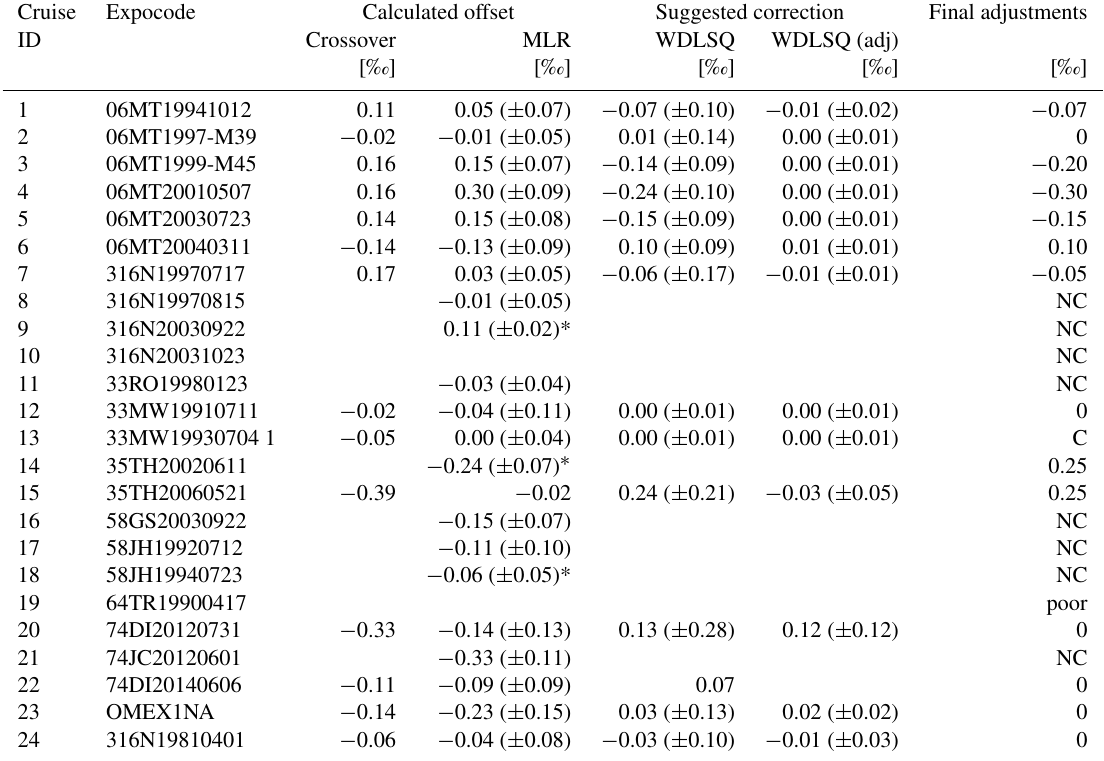
Table 4. Overview of all cruises in this dataset. The data of some cruises were combined for the analysis. For more information, please see the detailed description in the “Adjustments” section. The mean offsets of the crossovers and the MLR as well as the corrections suggested by the WDLSQ inversion for the original and the adjusted dataset are shown. In the last column the applied adjustments are displayed. NC indicates that these cruises were not considered in the inversion since they had no statistically significant crossover, and the core cruise is marked with C. Cruises with insufficient quality data are denoted “poor” and not included in the further analysis. Cruises marked with a ∗ had fewer than 10 deep samples that were part of the MLR